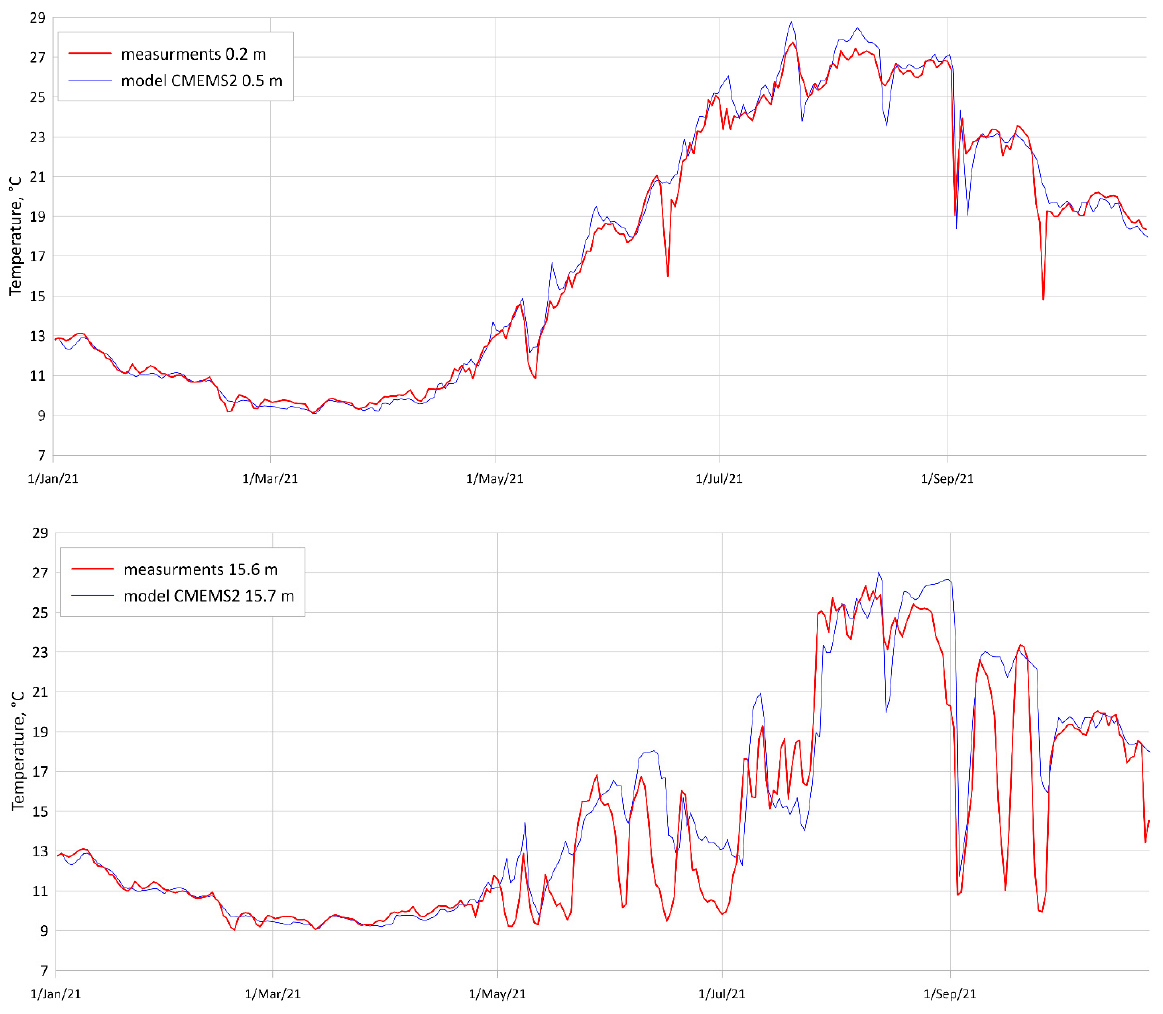
Figure 18. Water temperature at the surface and on the 15 m layer according to the measurements (red line) and CMEMS2 model data (blue line) from 1 January to 25 October 2021. Table 4. Main statistical parameters for MHI and CMEMS1/2